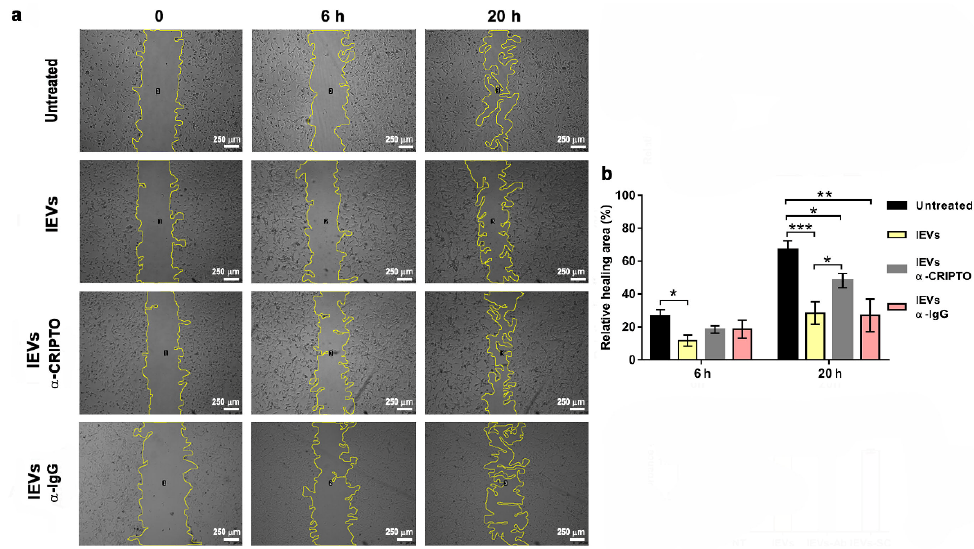
Figure 7. Rescue of U87 cell migration. ( a ) Cell migration at 0, 6, and 20 h of untreated U87 cells, U87 treated with NTERA2 large extracellular vesicles (lEVs) or NTERA2-lEVs previously incubated with anti-CRIPTO antibody (lEVs- α -Cripto) and a scramble antibody (lEVs- α -IgG), respectively. Open area is outlined by a yellow line and analyzed with ImageJ. ( b ) Relative wound healing area in the different conditions. Three independent experiments were performed, each in duplicate. Data are shown as means ± standard error of mean. Inhibitory effect of NTERA2-lEVs was partially rescued after 20 h when vesicles were pretreated with anti-CRIPTO antibody. Rescue was not observed when anti-IgG antibody was added. * p < 0.05; ** p < 0.01; *** p < 0.001.